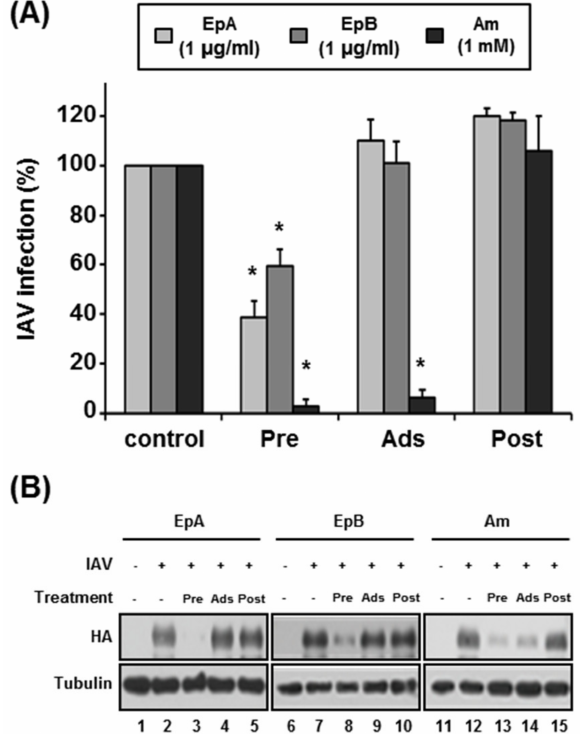
Figure 3. Virucidal activities of ethyl pheophorbides a and b. Following treatment of IAV with ethyl pheophorbide a (EpA) or b (EpB) at a concentration of 1 µ g/mL, experiments were performed as described for Figure 1A. ( A ) Viral RNA transcript levels were measured via qRT-PCR using primers specific for IAV M1 and GAPDH. Amantadine (Am), a M2 ion channel inhibitor (1 mM), was used as the control. Experiments were performed in triplicate and data expressed as GAPDH-normalized values relative to control. The viral RNA transcript level in DMSO-treated cells was set as 100%. * p < 0.05 (Student’s t -test). ( B ) Equivalent amounts of whole cell extracts were subjected to western blot analysis with antibodies specific for IAV HA and tubulin. Pre, pre-treatment; Ads, Adsorption; Post,